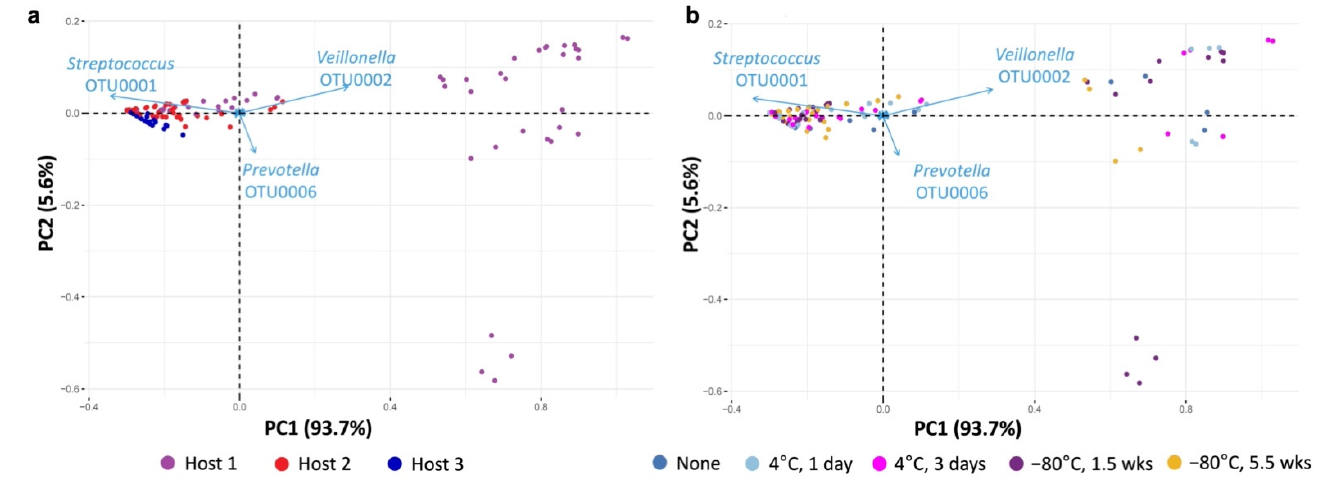
Figure 5. PCA biplots of relative abundances, by host ( a ) or preservation condition ( b ). Each dot represents a single sample (see legend). Arrows depict major OTUs in the dataset. Note the presence of a cluster of diminutively short arrows near the origin, containing OTUs that do not contribute substantially to the variation in the dataset. Dimension 1: Streptococcus OTU001 (–), Veillonella OTU002 (+); Dimension 2: Prevotella OTU006 (–), Veillonella OTU002 (+), Streptococcus OTU001 (+).